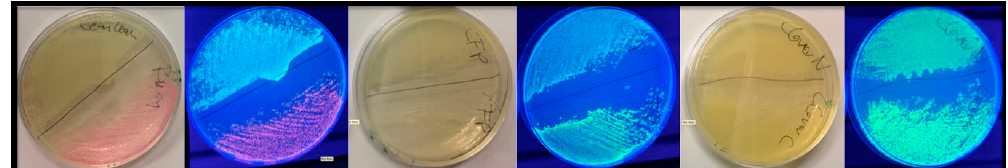
Figure A1. Constitutive expression of fluorescent proteins from the pNCS plasmid in the absence of arabinose. Escherichia coli BL21 AI were transformed with the expression plasmids indicated below, plated on ampicillin LB agar plates (2 transformations per plate) and incubated overnight at 37 °C. From left to right: (1) pNCS_mCerulean3_His/pNCS_mRuby3_His under visible light; (2) same plate under UV light; (3) pNCS_CFP_His/pNCS_YFP_His under visible light; (4) same plate under UV light; (5) pNCS-mClover3/pNCS_mClover3_His under visible light; (6) same plate under UV light.